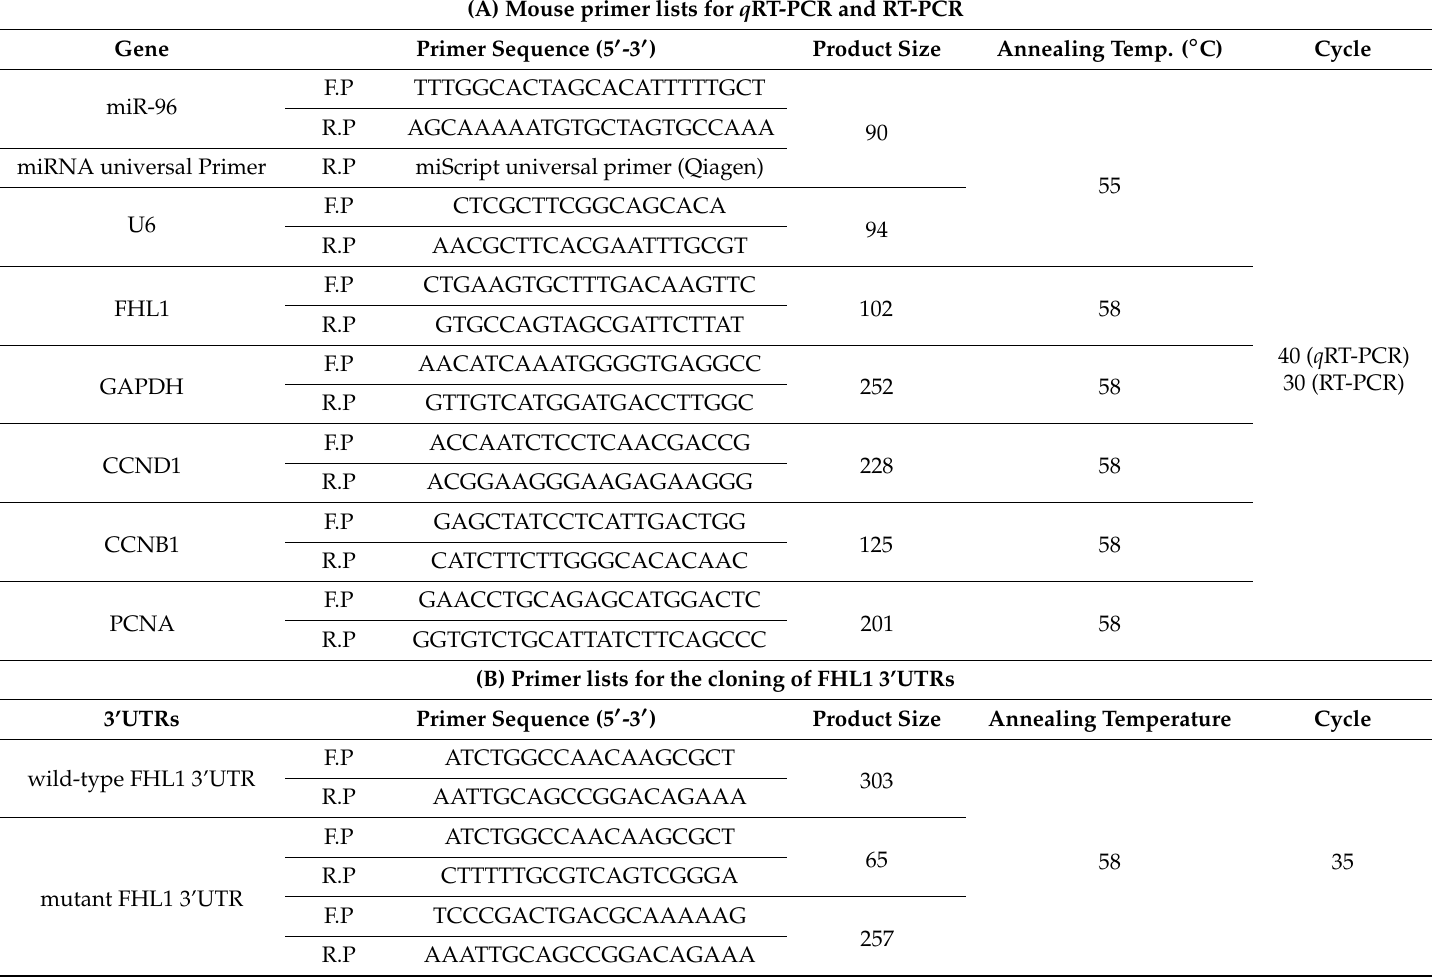
Table 1. Primer lists and PCR